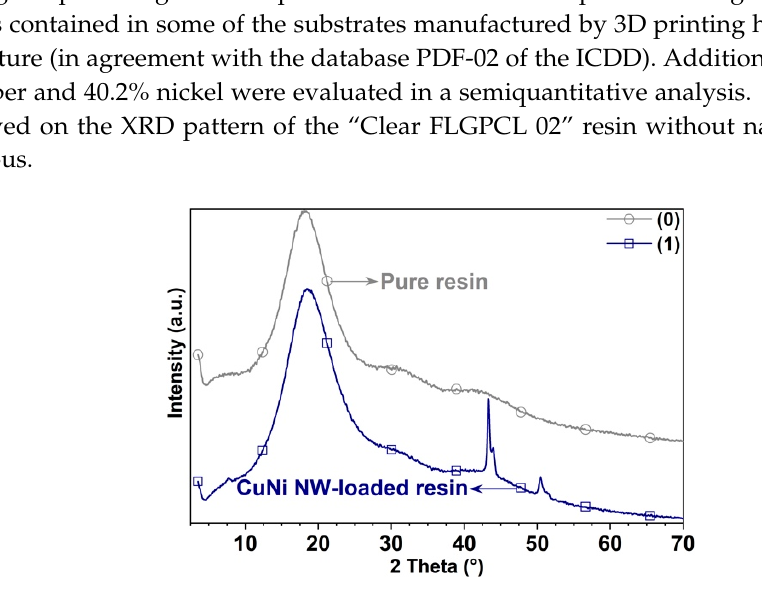
Figure 10. XRD patterns acquired on the substrates printed with (0) pure resin and (1) CuNi NW- loaded resin.